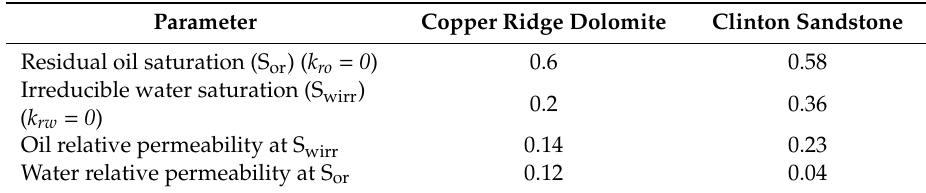
Figure 10. Clinton sandstone water–oil relative permeability to brine. Table 3. Relative permeability results.